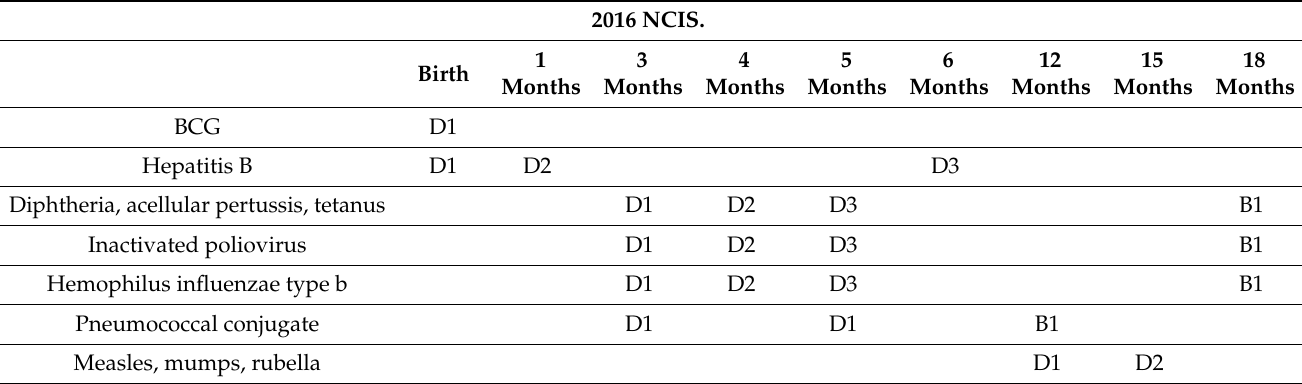
Table 1. 2016 National Childhood Immunization Schedule (NCIS) Singapore.